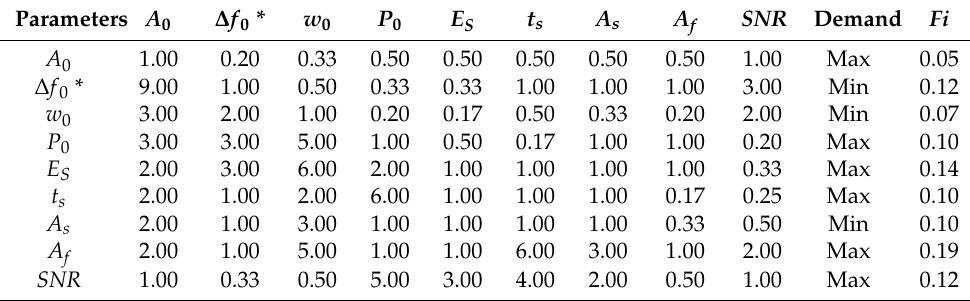
Table 2. Weights set for signal classification of each hammer–handle